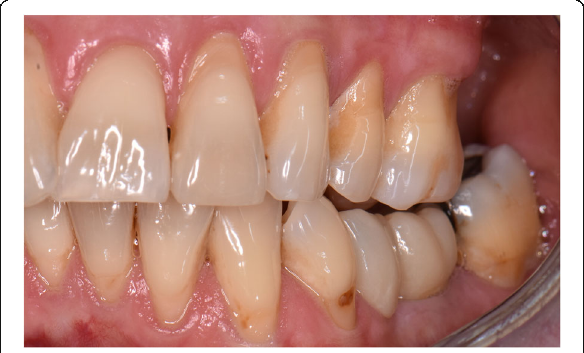
Fig. 1 Clinical case of a cantilevered 2-unit FDP (lateral view). The implant is placed in position 36, the cantilever pontic in position 35